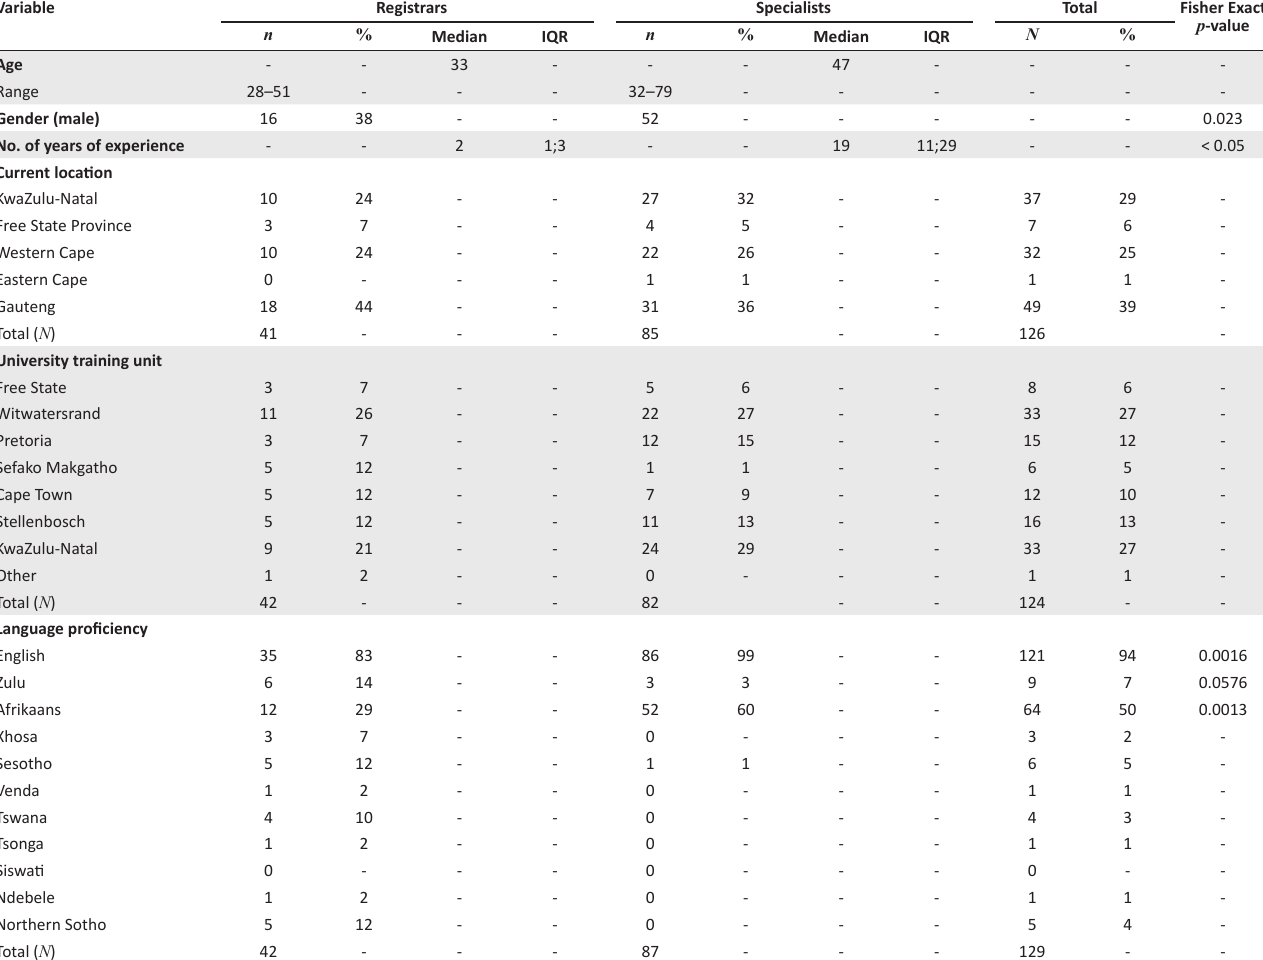
TABLE 1: Demographic data, current location, training units and language proficiency of